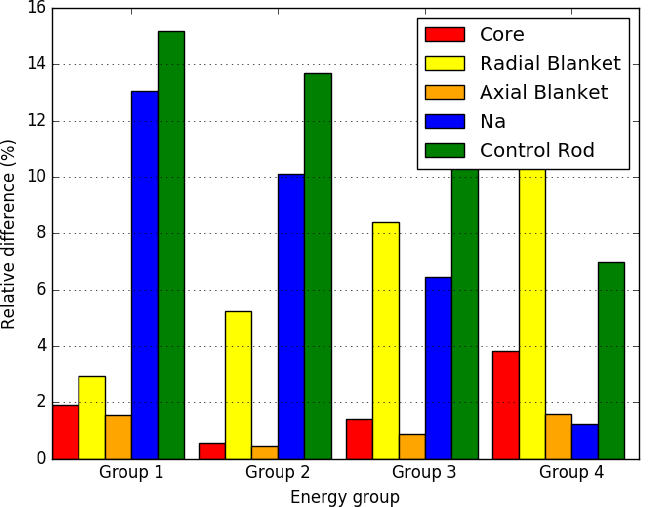
Figure 12. Comparison of region-averaged flux from reference and Parafish Model 2 Case 2.